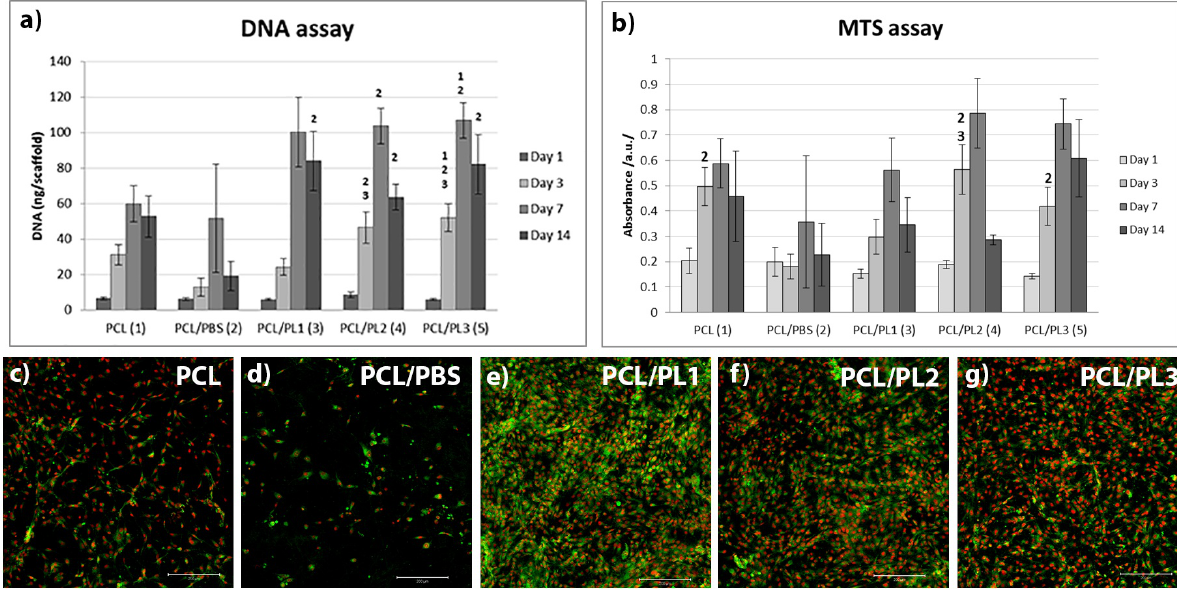
Figure 2. MG-63 adhesion and proliferation on scaffolds measured using DNA quantification (a) and cell metabolic activity measured using MTS test (b). Data were confirmed using confocal microscope. Cell nuclei were stained using PI (red colour) and cell membranes using DiOC6(3) (green). Scale 200 µ m, objective 10 ×